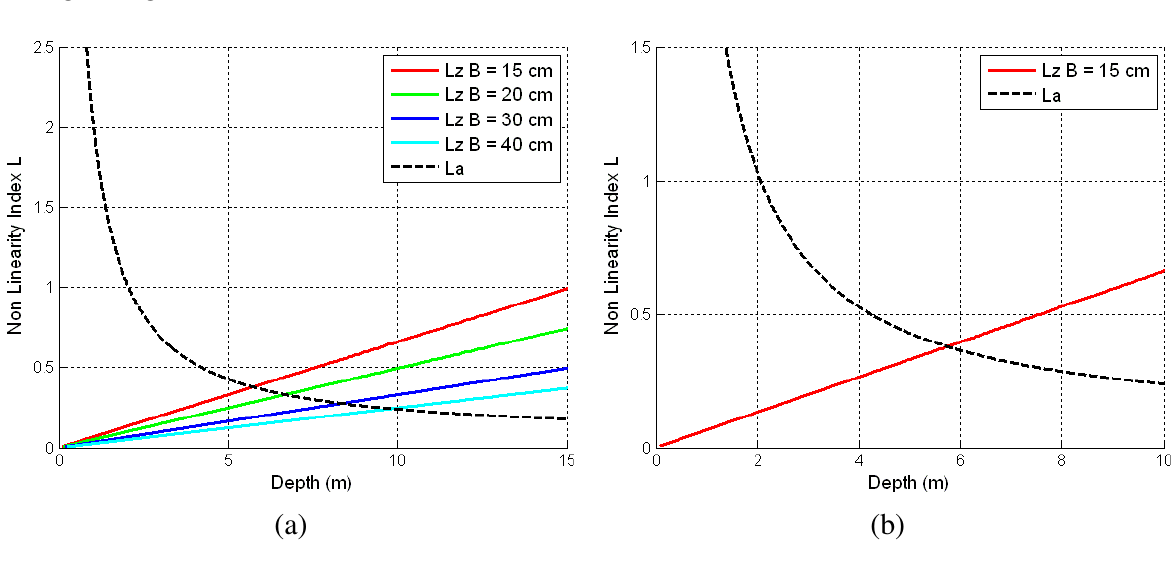
= 202 pixels and x